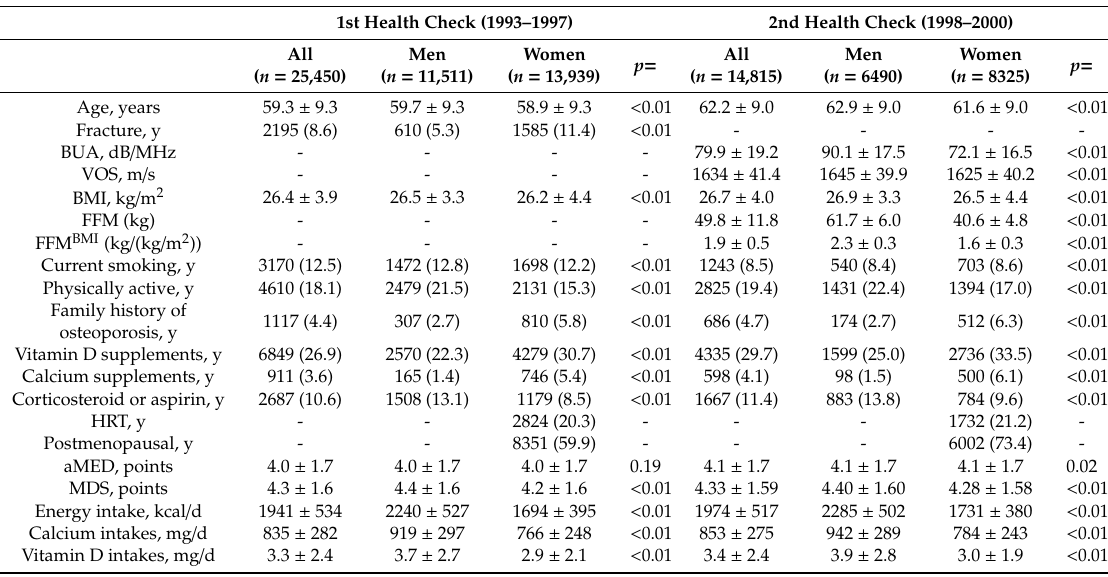
Table 1. Characteristics of participants in the EPIC Norfolk study at the first ( n = 25,450) and second ( n = 14,815) health checks, stratified by sex 1 .